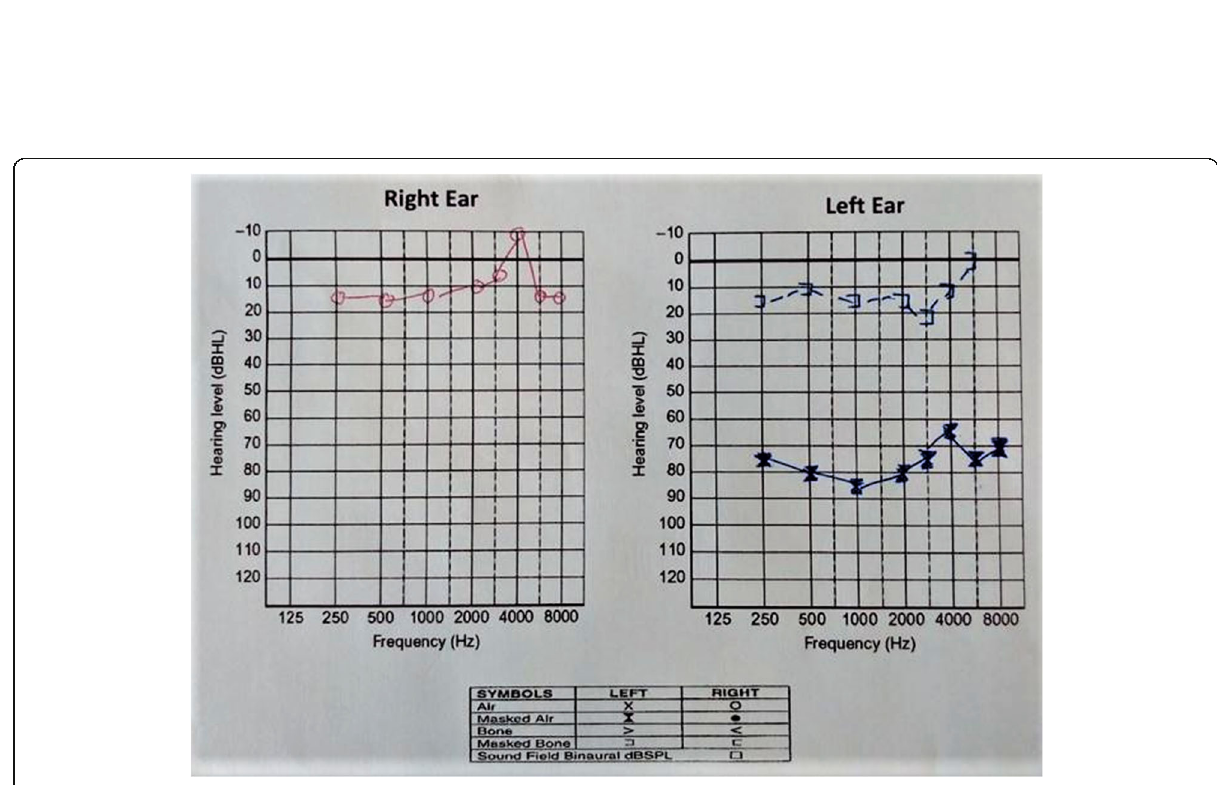
Fig. 2 Left ear showed a severe conductive hearing loss with air-bone gap of 50 – 60